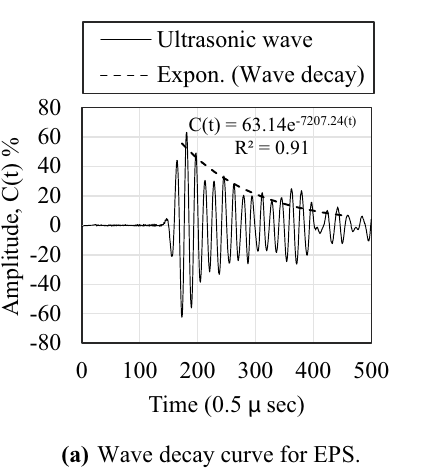
Fig. 6 Wave decay curves ( a ) for EPS, and ( b ) for